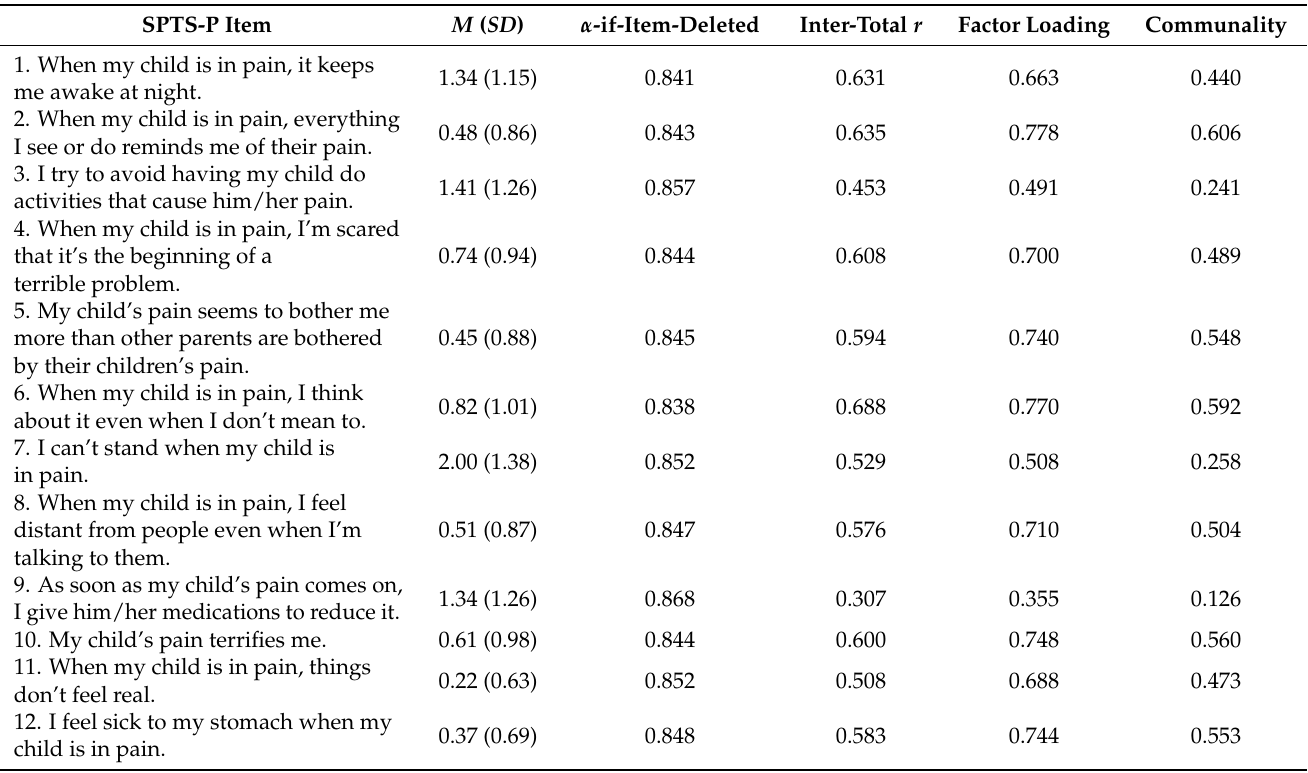
Table 3. Item-total statistics and factor loadings for the one-factor solution of the